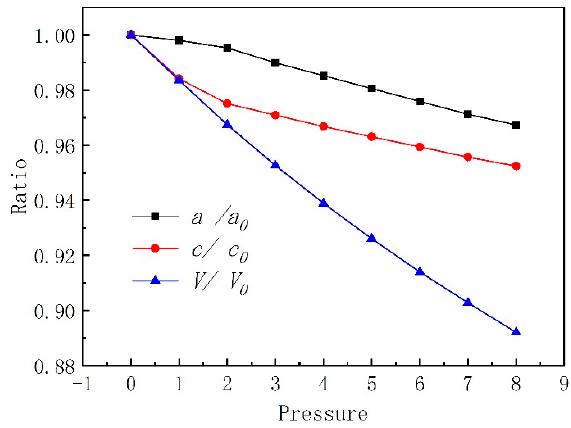
Figure 2. Variation trend of unit cell parameters of Mg 23 Al 30 under different pressures.